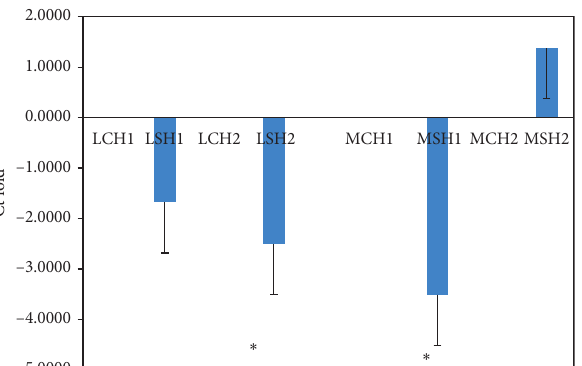
Figure 2: Comparison of relative fold change in the gene expression of leptin receptor (LEPR) in liver (L) and magnum (M) tissues of Nicobari chicken after 10 d (CH1 and SH1) and 20d (CH2 and SH2) of the experiment. ∗ P < 0 . 05. C: control; S: supplemented with FYC at 700mg/kg N � 4. From 21 to 23 weeks of age, the CH and SH group birds were exposed to 39 ° C for 4h under controlled